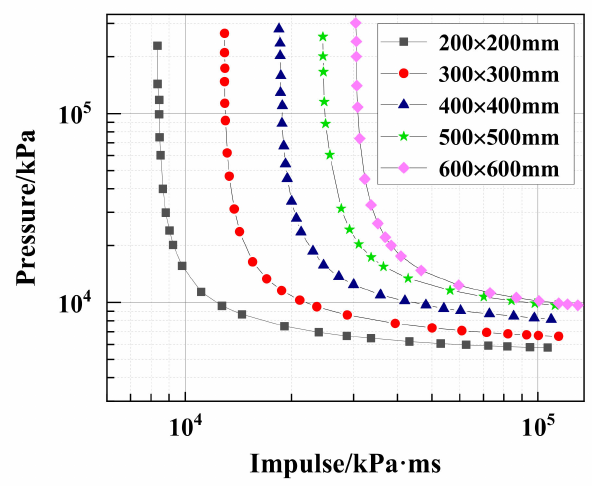
Figure 16. P-I curves of shear response with a different cross-sectional